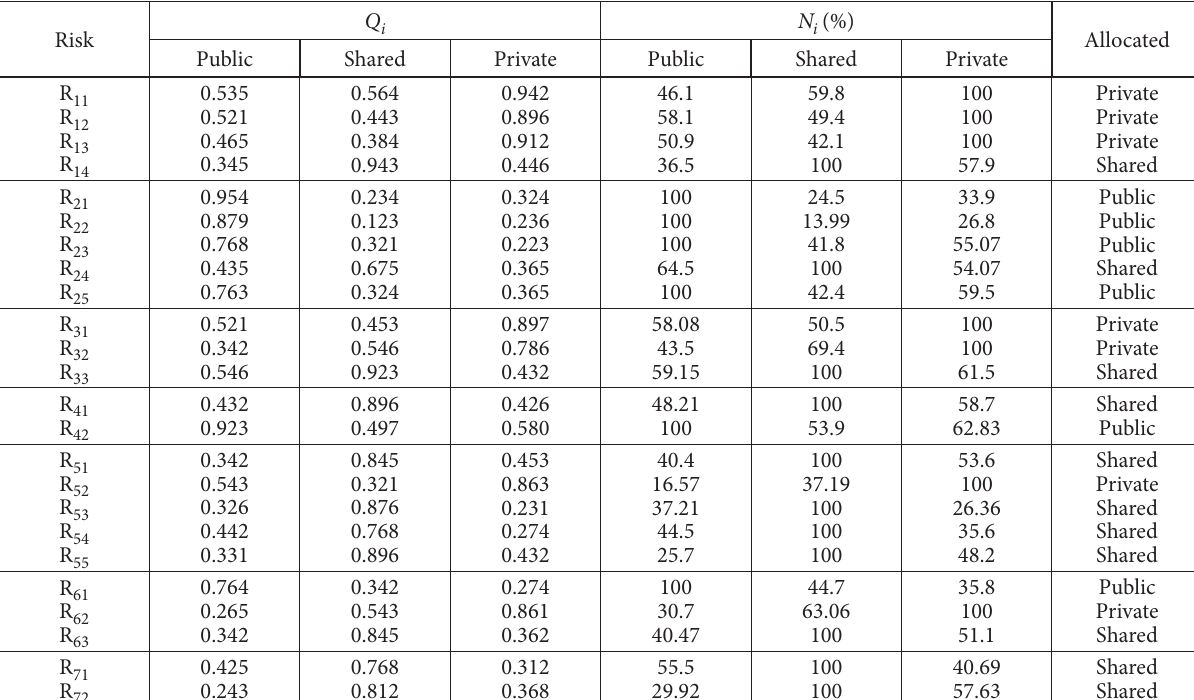
Table 10. Result of risk allocation in PPP water and sewerage projects in